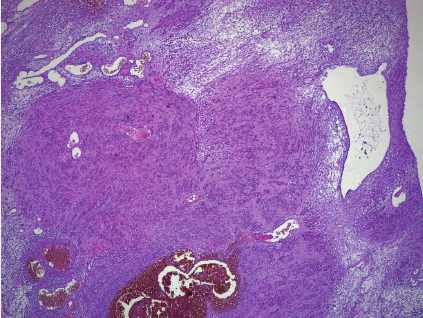
Figure 3: Microscopic photograph of the lesion reveals ancient form schwannoma. Hyaline degeneration and edema on the ground. Undulant and hypocellular Schwann cells are placed as clusters. compression at the level of sciatic notch due to schwannoma [8,